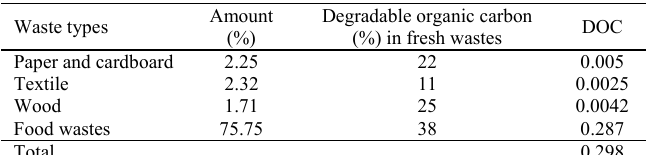
Table 1: Data used for DOC calculation